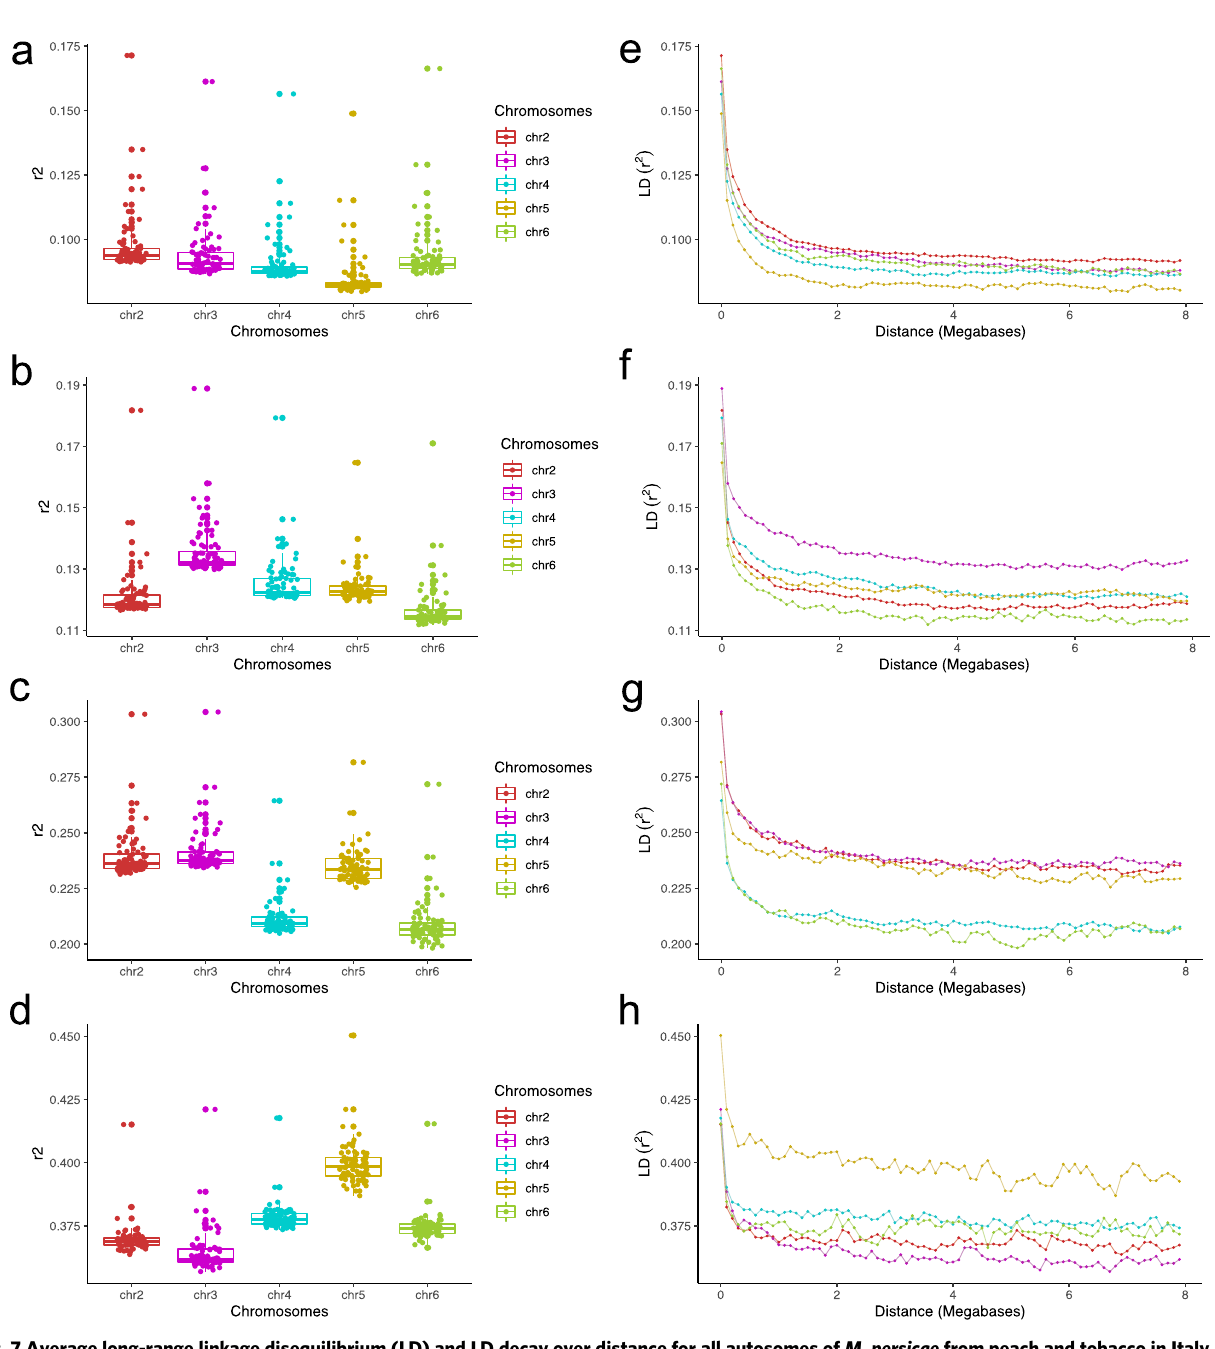
Fig. 7 Average long-range linkage disequilibrium (LD) and LD decay over distance for all autosomes of M. persicae from peach and tobacco in Italy and Greece. Distribution of r 2 is plotted separately for all autosomes in clones from a peach-Greece, b peach-Italy, c tobacco-Greece and d tobacco-Italy. See Supplementary Data 1 for sample sizes. Individual points in the box plot represent mean r 2 values in 100 KB windows along the entire length of autosomes. r 2 values are plotted as a function of distance (LD decay) across all autosomes in e peach-Greece, f peach-Italy, g tobacco-Greece and h tobacco-Italy